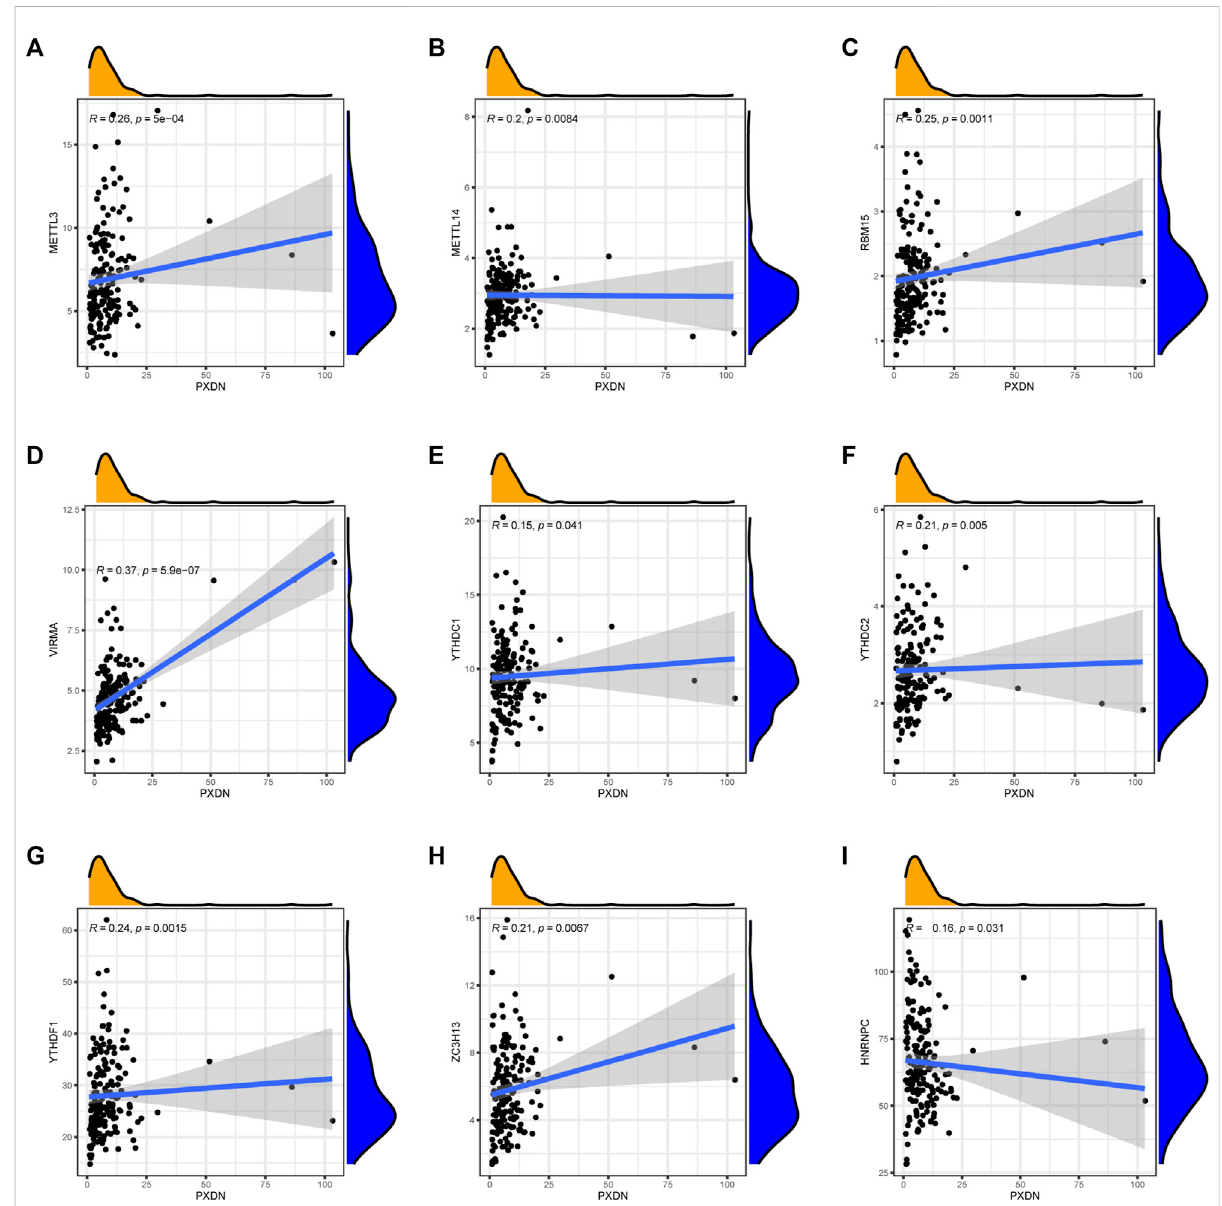
FIGURE 7 Association of PXDN expression with m6A-related markers. (A) METTL3. (B) METTL14. (C) RBM15. (D) VIRMA. (E) YTHDC1. (F) YTHDC2. (G) YTHDF1. (H) ZC3H13. (I)